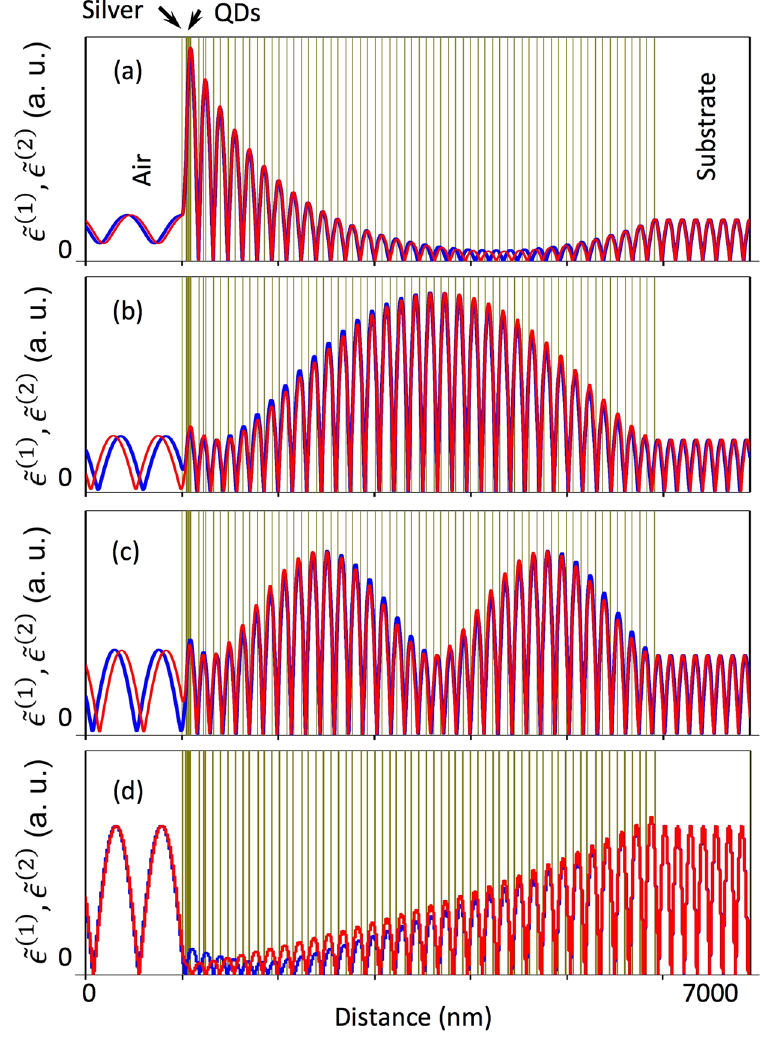
Figure 4. Functions  (1)  (blue lines) and  (2)  (red lines) for: ( a ) Tamm plasmon mode at normal incidence ( θ = 0, ω =  1.2462 eV); ( b ) edge state ( θ = 0,  ω = 1.3247 eV); ( c ) edge state ( θ = 0,  ω = 1.3509 eV); ( d ) photonic band gap ( θ = 0, ω =  1.31 eV). Corresponding points at emission pattern are shown by arrows at Fig.